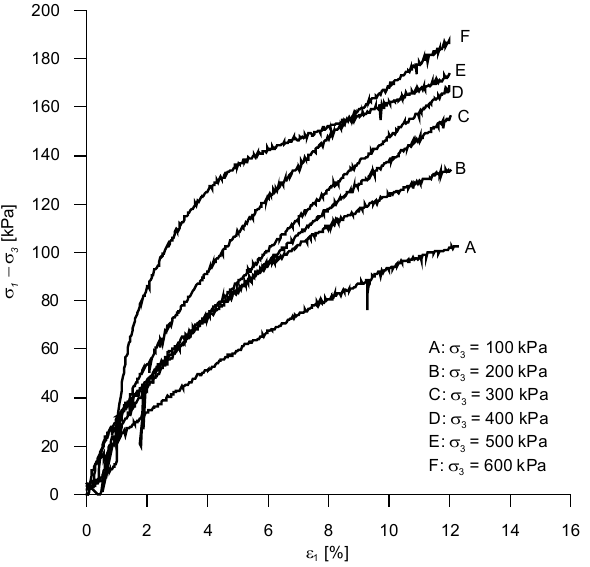
Figure 9: Illustration of the results of strength tests of soil of firm consistency (A-2 and B-2) from one sample.